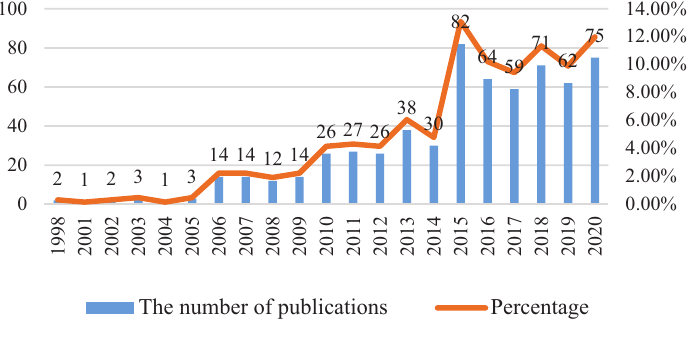
Figure 4. Distribution of papers by publication year